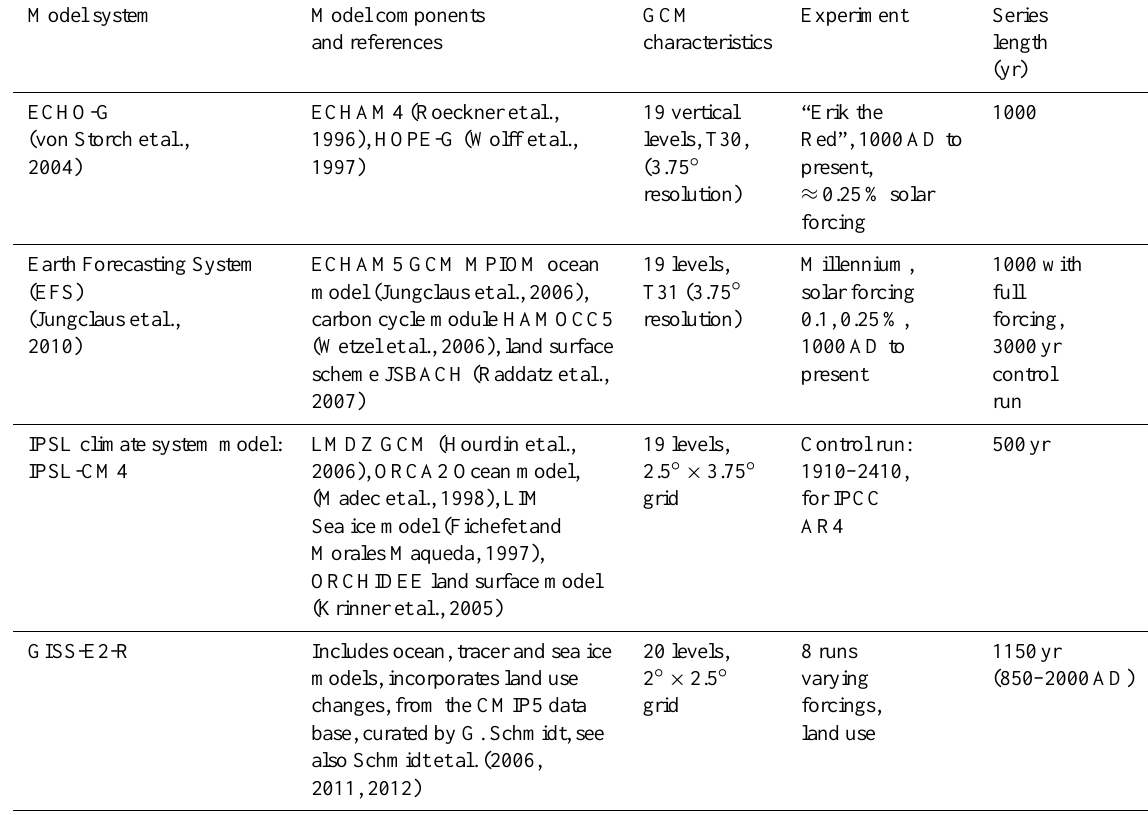
Table 3. Details of the climate